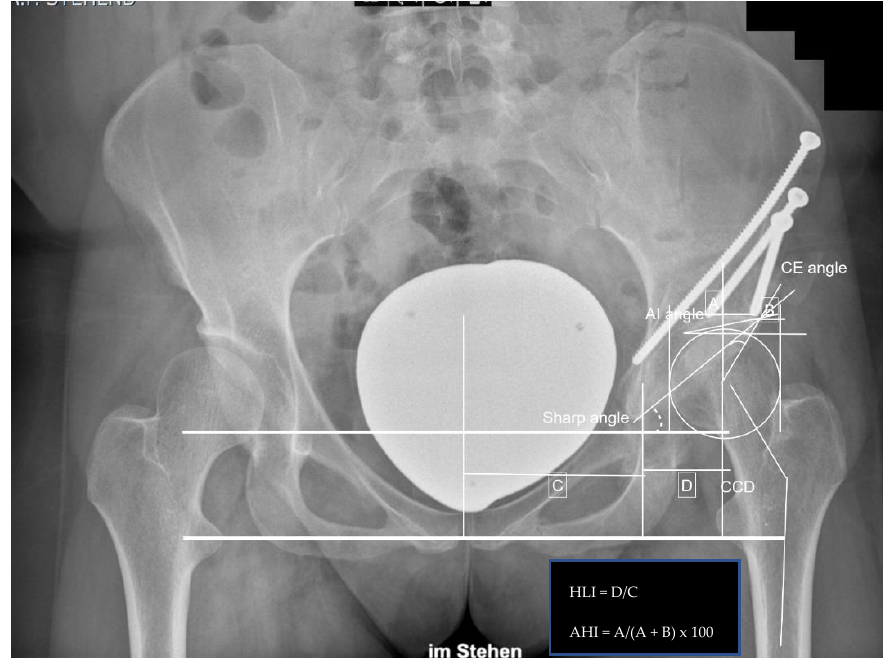
Figure 3. Postoperative measurements after left-sided PAO: CE angle 38.0°, AIA − 0.5°, sharp angle 36.5°, hip lateralization 0.56, anterior hip index 91.4, CCD angle 137.4°, and positive crossing-over sign.